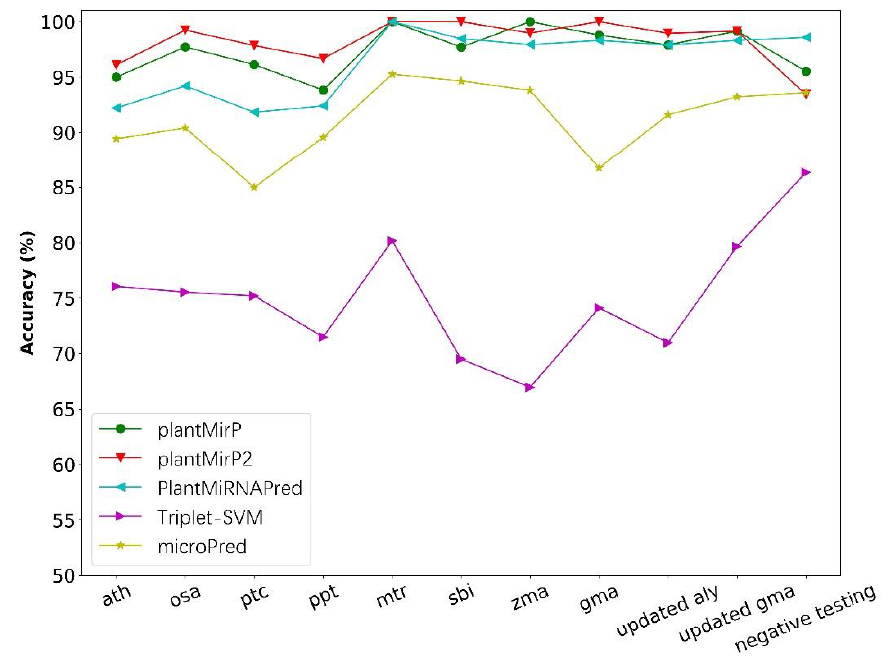
Figure 10. Based on the training and testing datasets from PlantMiRNAPred, the prediction accuracies of plantMirP, plantMirP2, PlantMiRNAPred, Triplet-SVM and microPred were compared.